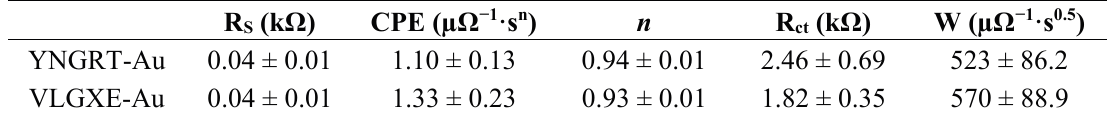
Figure 4. ( A ) Cyclic voltammograms and ( B ) Nyquist plots of YNGRT-Au (a) and VLGXE-Au (b) surfaces. Table 1. Impedance parameters fitted for YNGRT-Au and VLGXE-Au surfaces using the equivalent circuit in Figure 4B (inset).